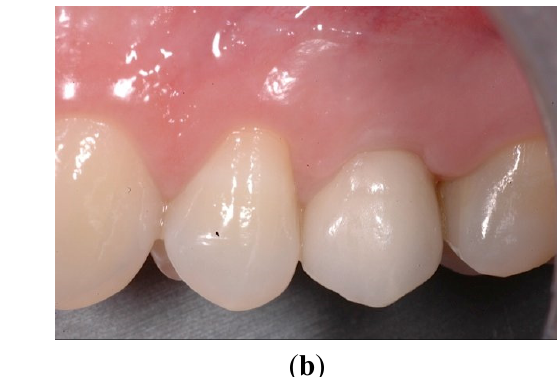
Figure 6. Peri-apical X-rays at one-year follow-up. ( a ) Position 15; ( b ) Position 25.